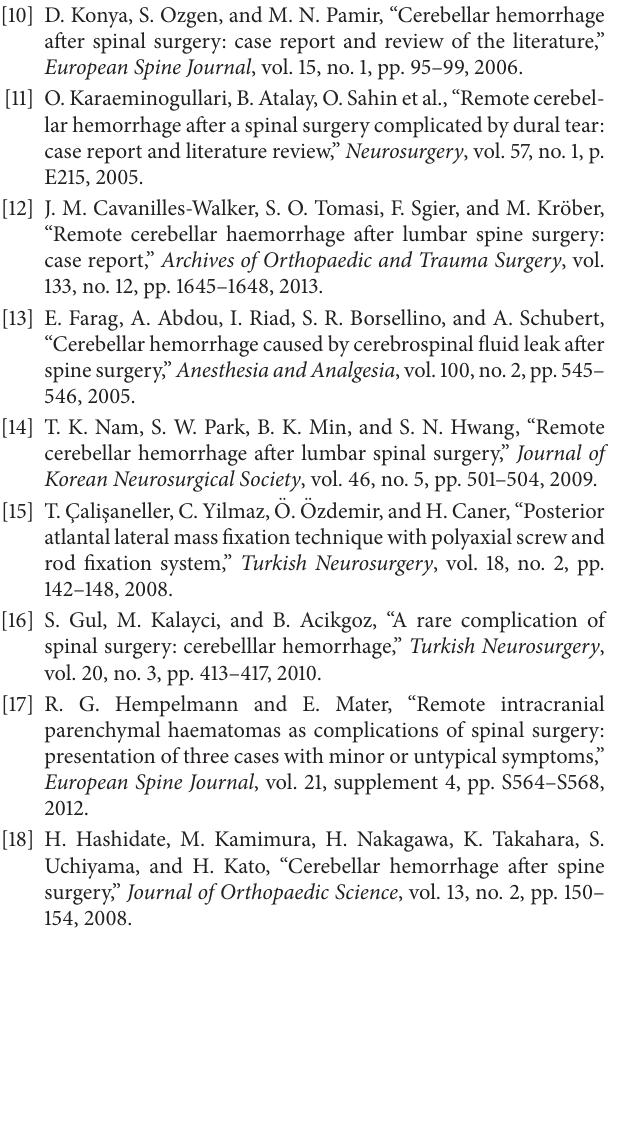
(Table 2). Postoperative outcomes included death at 16